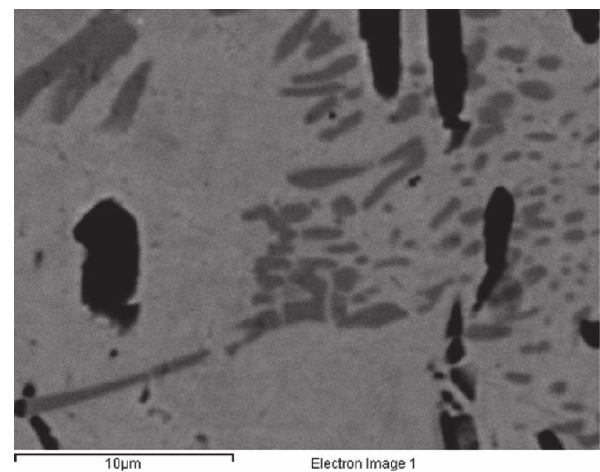
Fig. 13: SEM-BSE image of Cr rich phase in experiment 9 FeCr23 (10 min)